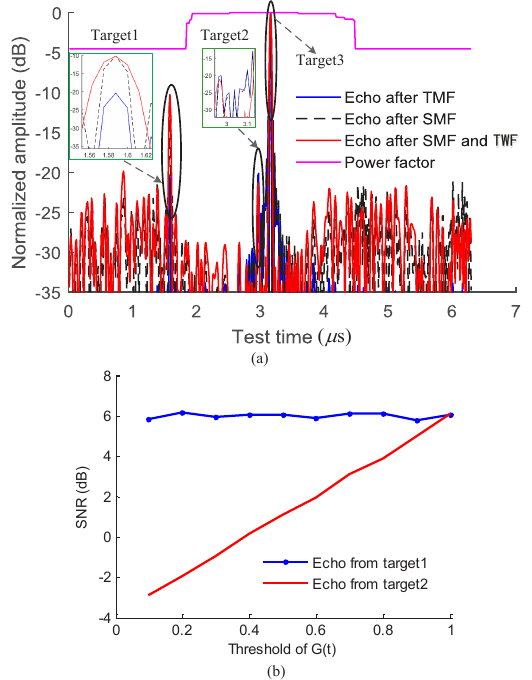
Figure 4. ( a ) Comparison of SMF and TMF; ( b ) The SNR of the small target echo corresponding to the threshold of the power